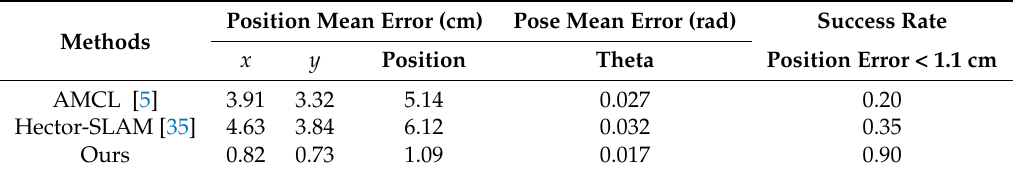
Table 2. The result of the